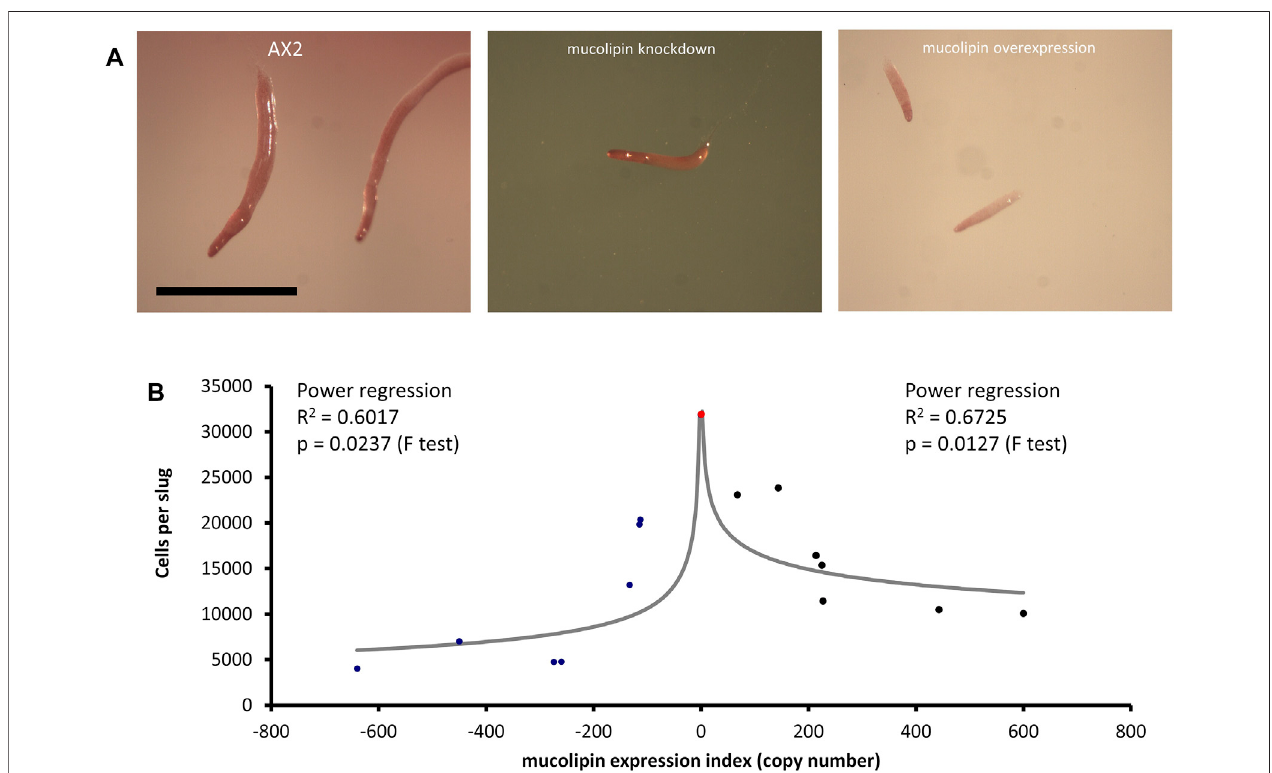
FIGURE 9 | Slug sizes are smaller in mucolipin knockdown and overexpression strains and is copy number dependent. (A) Slugs formed after ~16 h of development on water agar. Mutants formed smaller slugs than AX2 Scale bars = 1 mm. (B) Both increasing and decreasing mucolipin expression reduces aggregate size. The aggregate size of overexpression and knockdown strains was quanti fi ed by determining the number of cells per slug. The mean aggregate size for each transformant was determined by isolating single slugs and counting the number of cells in each slug using a haemocytometer ( n = 30). The mean aggregate size was reduced in a copy number dependent manner, the regressions were signi fi cant indicated by the p values. Positive copy numbers represent overexpression strains and negative numbers knockdown strains, AX2 had a copy number of 0 as it contains neither plasmid (indicated as red circle).